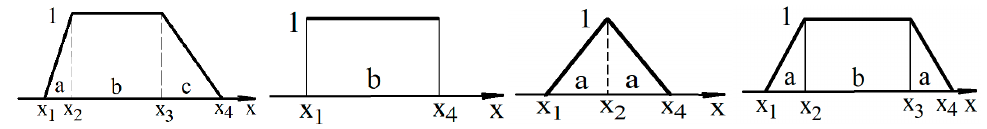
Figure 7. Considered membership functions.